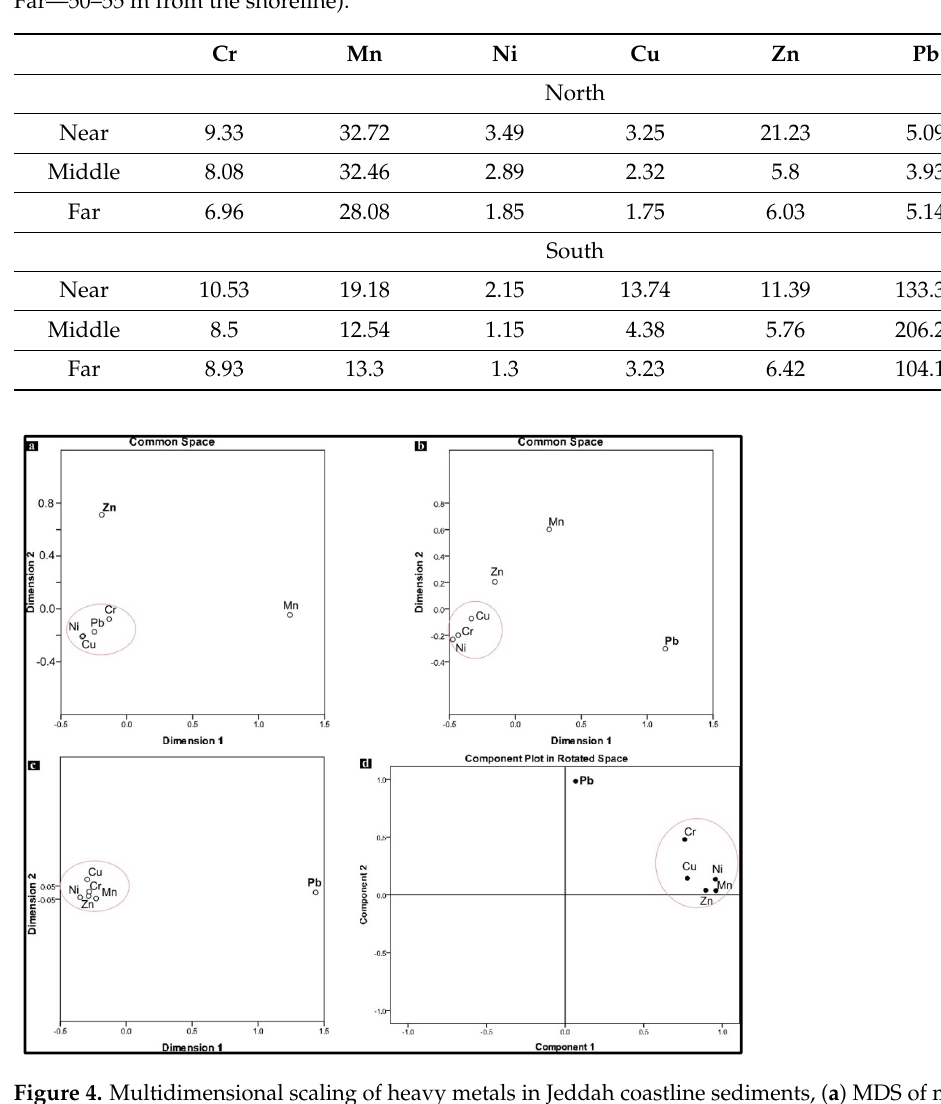
Table 7. The average concentrations (mg/kg) of heavy metals in the North and South locations with different distances from shoreline (Near—at the shoreline; Middle—25–30 m from the shoreline; Far—50–55 m from the shoreline).